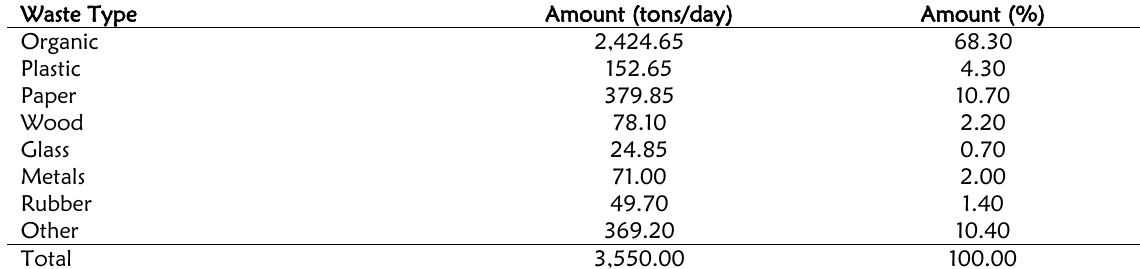
Table 1: Waste generation in Dhaka city [18]